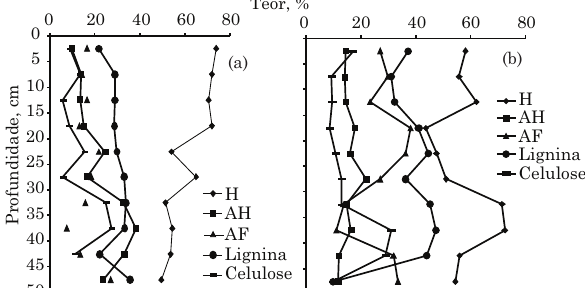
Figura 4. Teores médios de humina (H), ácidos húmicos (AH), ácidos fúlvicos (AF), lignina e celulose (% MOS), em profundidade sob: (a) Campo Limpo Úmido (CLU); e (b) Floresta Estacional Semidecidual